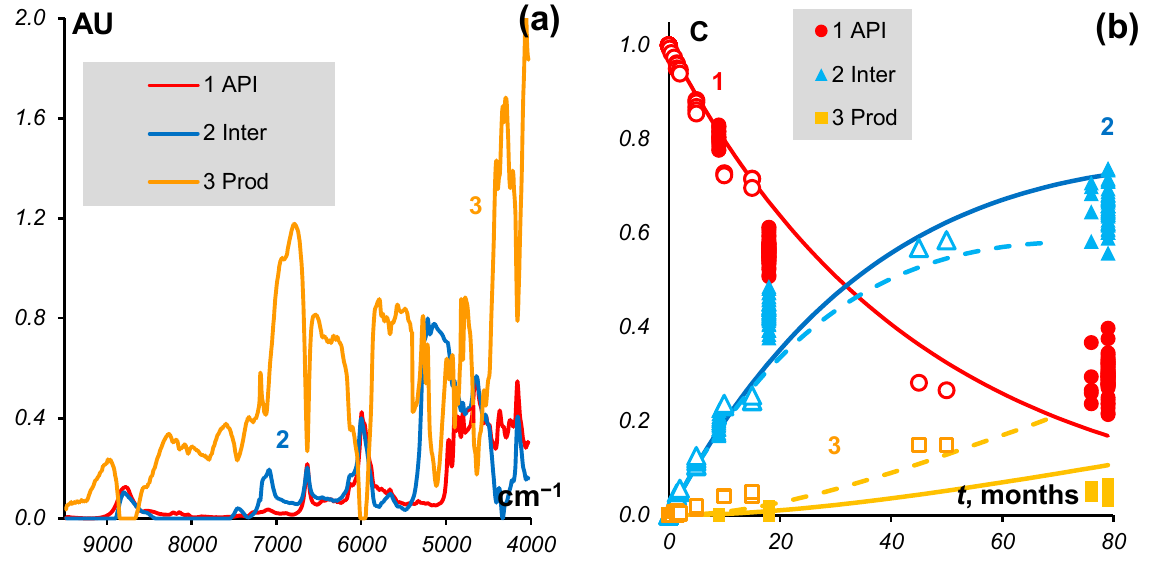
Figure 7. MCR model for the combined data. ( a ) Spectra of API , Inter , and Prod . ( b ) Concentrations (markers) and kinetics (curves). Solid curves and closed markers are for tablets, dashed curves and open markers are for substances.